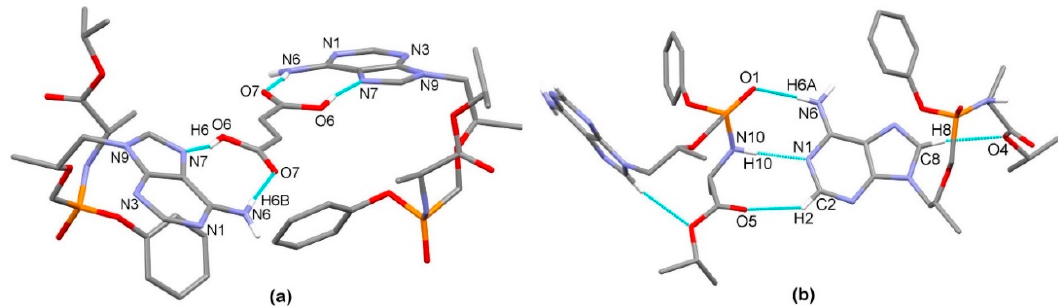
Figure 5. Hydrogen bond architecture in the TA HF co-crystal. ( a ) Hydrogen bonding between both carboxylic groups of fumaric acid and two adjacent tenofovir alafenamide molecules; ( b ) Hydrogen bonding between adjacent tenofovir alafenamide molecules and intramolecular hydrogen bonding. Hydrogen bonds are drawn with dashed blue lines. Hydrogen atoms not involved in the shown motif have been omitted for clarity. The disorder of the isopropyl and phenyl groups is omitted for clarity.